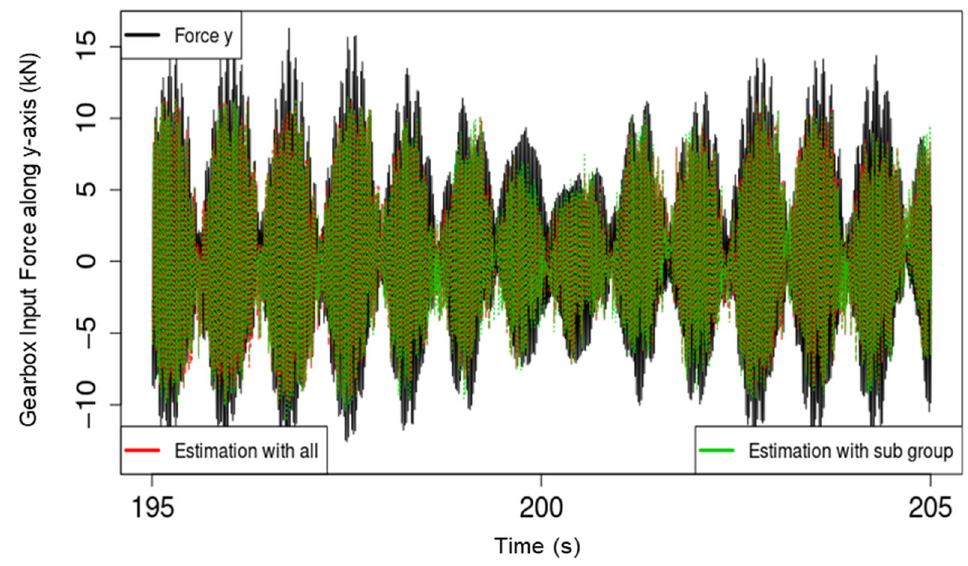
Figure 6. Plot of force along the y-axis, model estimations with all predictors, and with only the highly important subset of predictors.